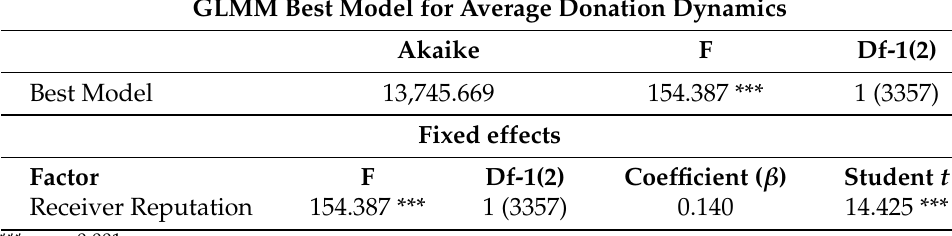
Table 7. Generalized Linear Mixed Models 5. Average